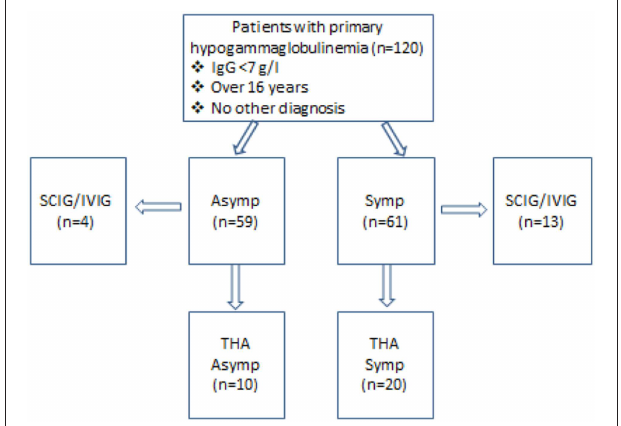
FIGURE 1 | Characteristics of patients enrolled in this study. Fifty-nine patients were asymptomatic while 61 had symptoms, which could be attributed to the immune defect. Thirteen symptomatic (Symp) and four asymptomatic (Asymp) patients were accepted for SCIG/IVIG. THA-transient hypogammaglobulinemia of adulthood, with IgG increasing to ≥ 7.0